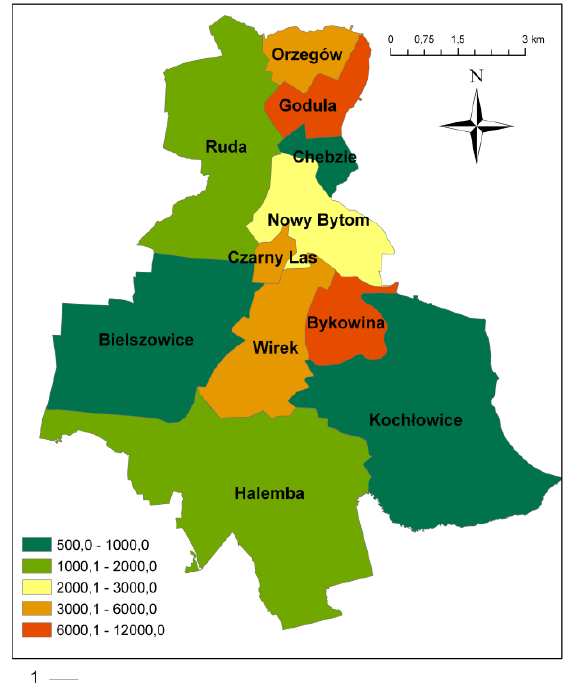
Fig. 1. Population density in Ruda Śląska districts in 2005 (after Lokalna strategia zatrudnienia, 2008)